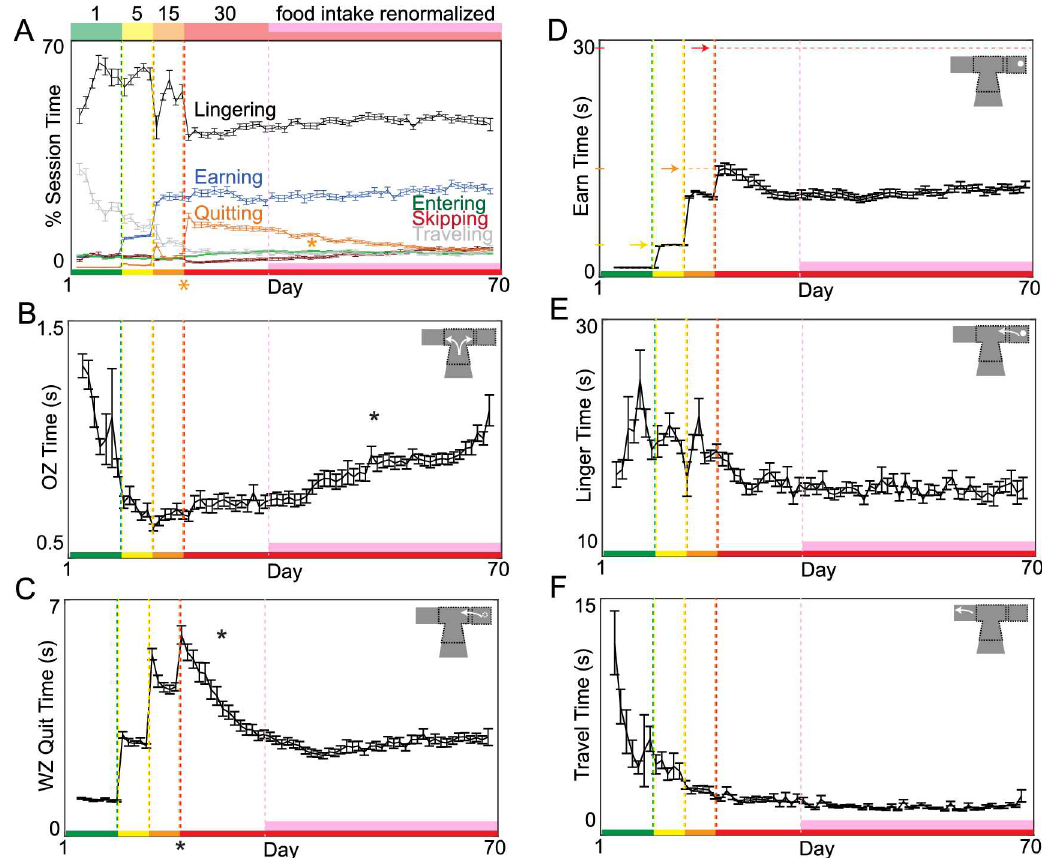
Fig 3. Allocation of a limited time budget among separable decision processes. (A) Cumulative time spent engaged in various separable behaviors and decision processes calculated as percent of the total 1 h daily session’s time budget. (B) Average time in the OZ from offer onset upon restaurant entry until either a skip or enter decision was made. (C) Average time in the WZ from countdown onset until a quit decision was made. (D) Average time in the WZ from countdown onset until a pellet was earned. (E) Average time near the reward site from pellet delivery until mice exited the WZ and entered the hallway, advancing to the next restaurant. (F) Average time spent traveling in the hallway between restaurants between trials (from either a skip, quit, or postearn leave decision until the next trial’s offer onset upon subsequent restaurant entry). Data are presented as the cohort’s ( N = 31) daily means ( ± 1 SE) across the entire experiment. Color code on the x-axis reflects the stages of training (offer cost ranges denoted from 1 to the number on the top of panel A). Vertical dashed lines (except pink) represent block transitions. (cid:3) on the x-axis indicates immediate significant behavioral change at the block transition; otherwise, (cid:3) indicates gradual significant changes within the 1 − 30 s block during either the early 2 wk adaptation period or late pink epoch. Data available as a supplemental file. OZ, offer zone; WZ, wait